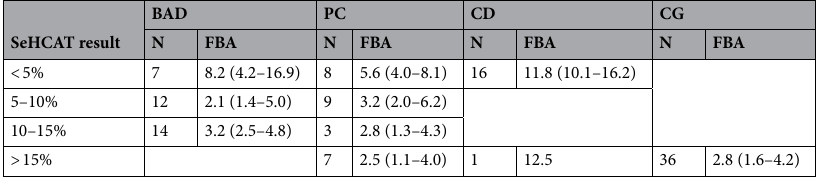
Table 1. Total number (N) of patients and median FBA concentrations with IQR in each patient cohort based on their SeHCAT result. BAD idiopathic BAD, PC post-cholecystectomy, CD post-operative Crohn’s disease patients, CG SeHCAT negative control group.